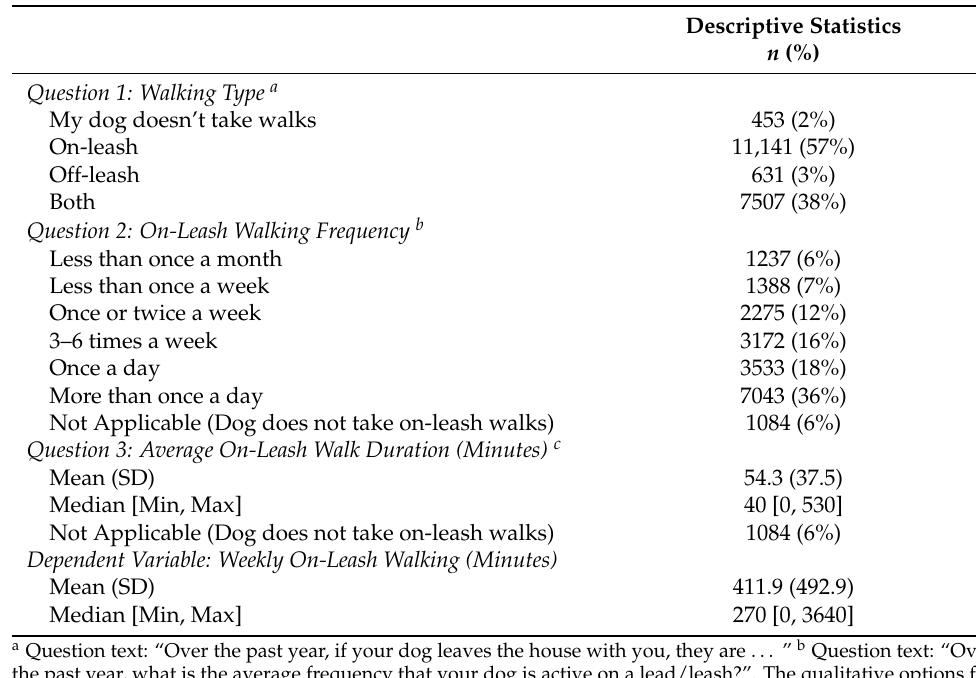
Table 1. Distribution of Dog Aging Project Participants by Components of Summary “Dog Walking” Variable ( n = 19,732). Dog Aging Project, 2019–2020.